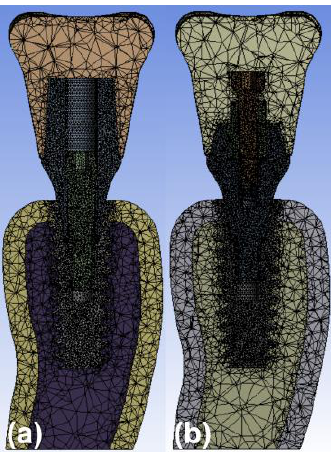
Figure 2. Meshes formed for the model with the properties of each component. The colors of cortical and cancellous bone are different, as are those of the implant and crown. ( a ) Cement-retained and ( b ) cementless screw-retained zirconia crown models.